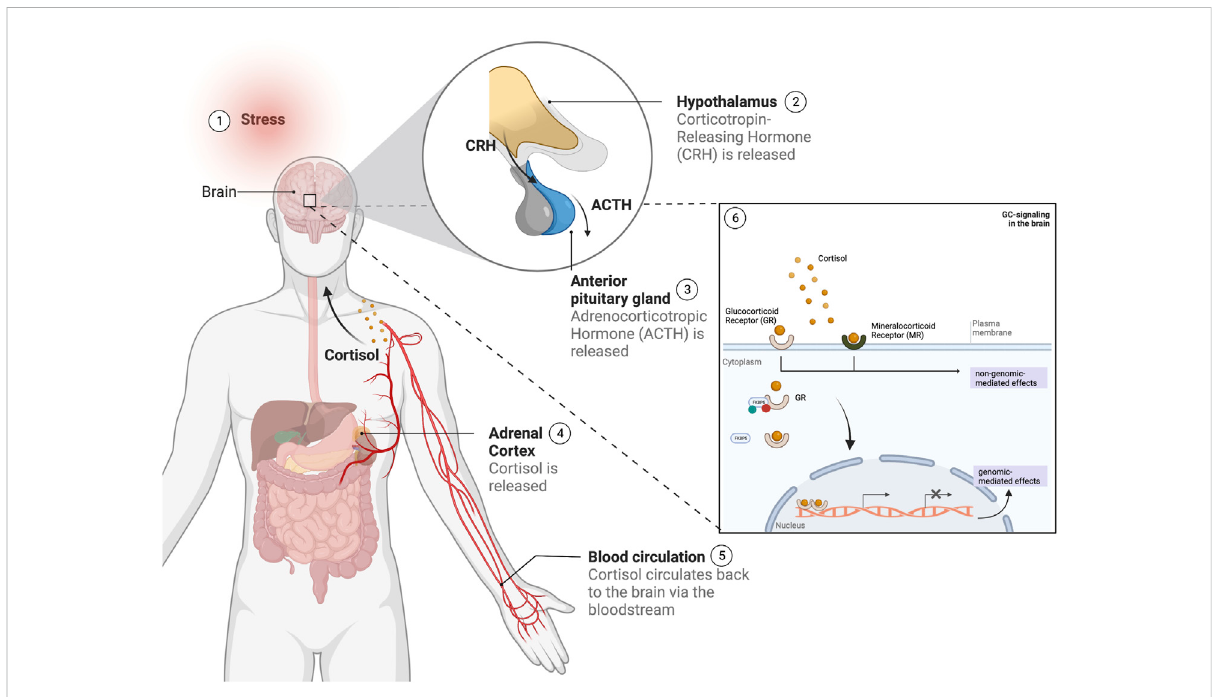
FIGURE 2 Overview of the stress response in humans following a stress stimulus. 1) Upon the experience of a stress stimulus, 2) the hypothalamus is activated and releases 'corticotropin-releasing hormone (CRH), which leads to the 3) activation of the anterior pituitary gland to